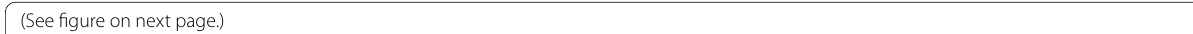
200 voxels). B Surface rendering with hypermetabolic = 15, 75, 17 L calcarine], see Table 2) and − − = 12, 38, 5 L parahpc gyrus], see Table 2) shows no overlap; CON scan number − − − =